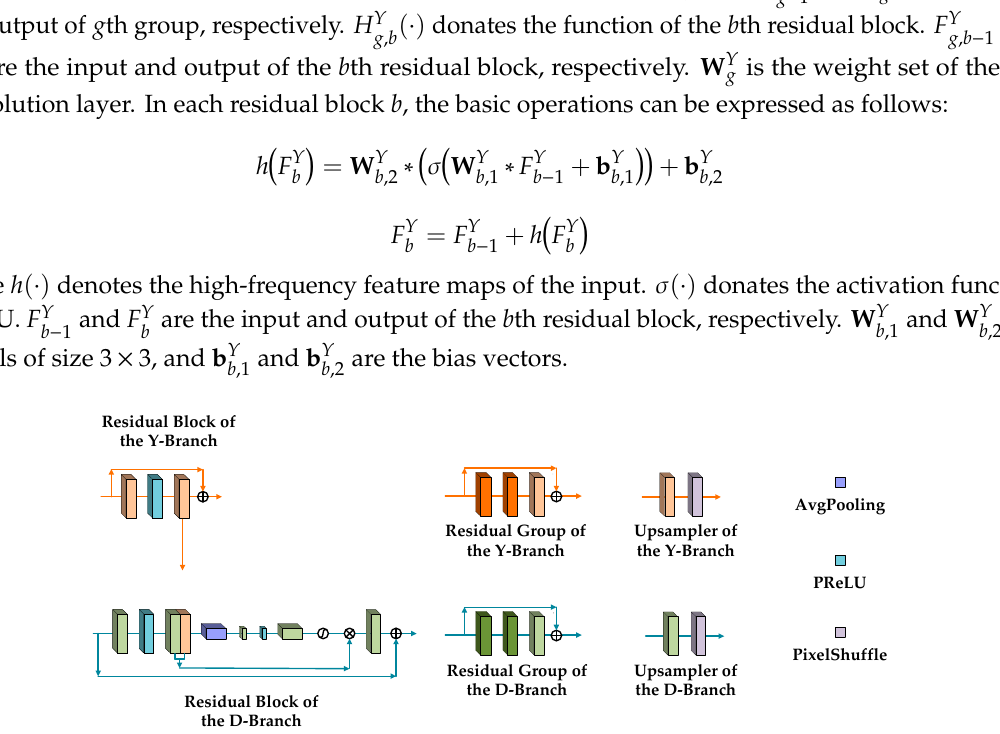
Figure 2. The structure of residual block, residual group and upsampler.